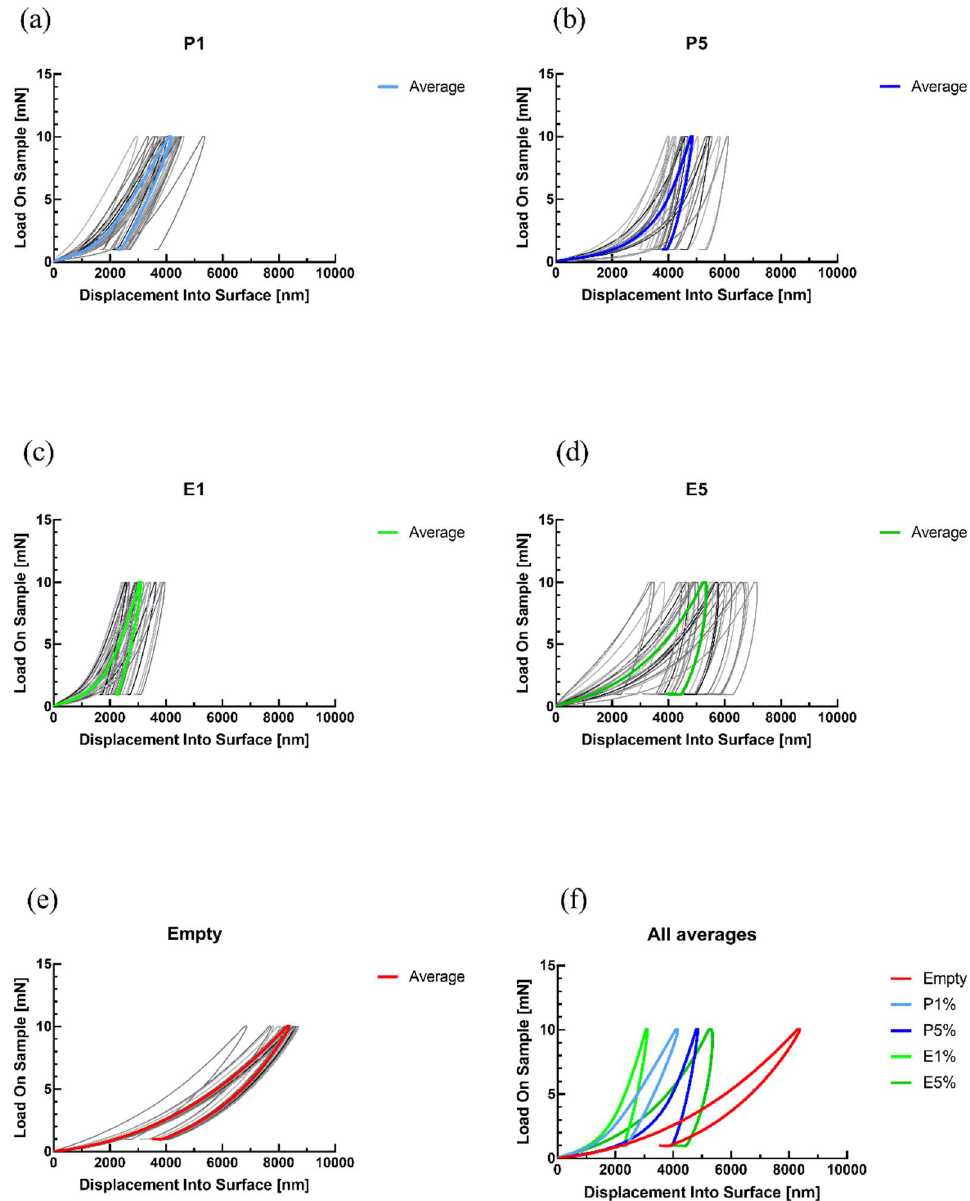
Figure 3. Nanoindentation results of microfluidic chip with ( a – d ) 1% and 5% of peppermint and eucalyptus essentials oils, ( e ) nanoindentation of dry chip before using any liquid sample, ( f ) average values of all samples.